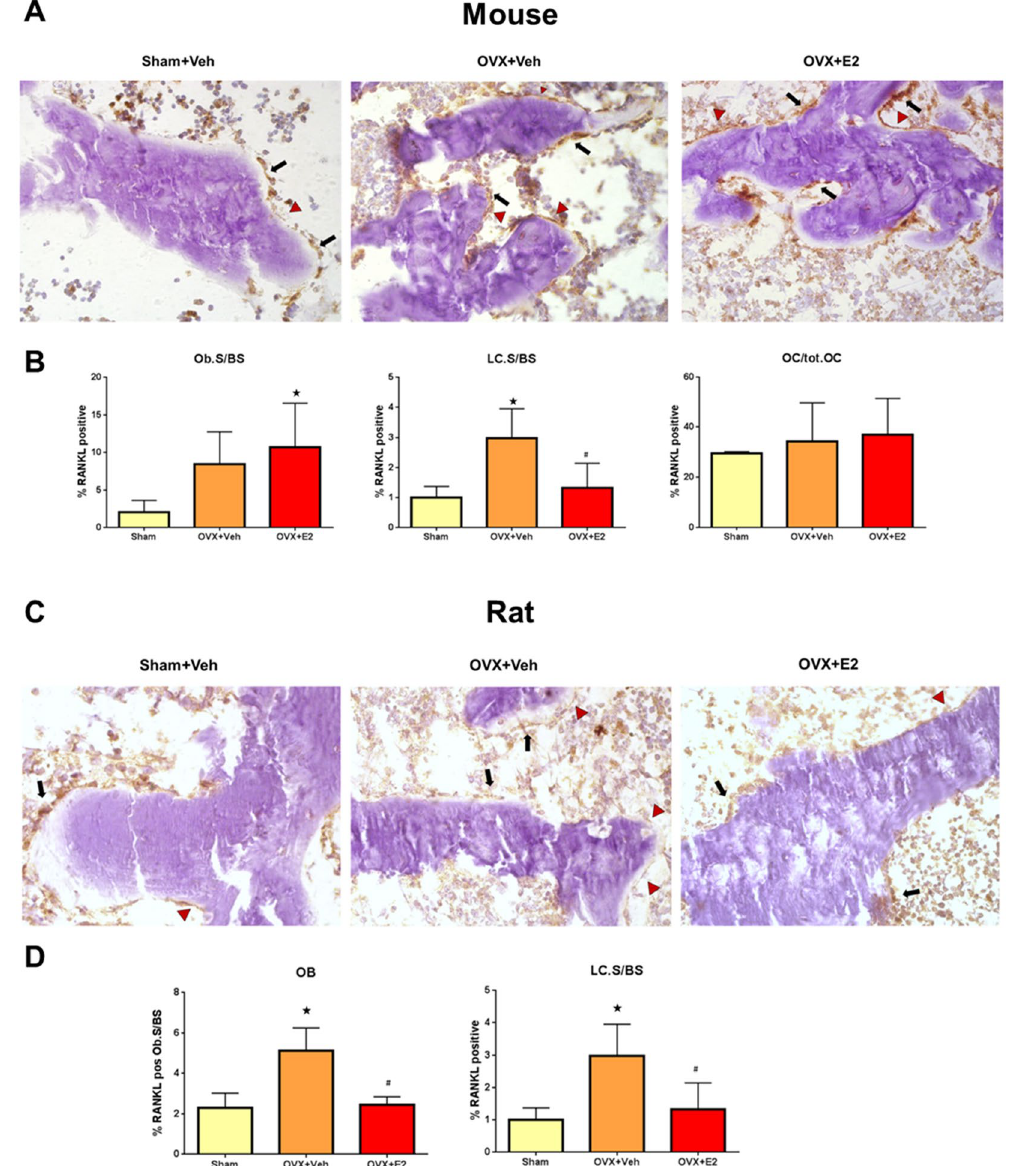
Figure 3. Estradiol targets RANKL expression in bone lining cells. ( A ) Anti-RANKL immunohistochemistry on cryosections of undecalcified distal femurs in vehicle-treated SHAM, and vehicle- or 17ß-estradiol (10 µ g/kg in B/R 5 times per week)-treated OVX WT mice, 2 weeks post-OVX. ( B ) Percent RANKL-positive osteoblasts per bone surface (BS), percent RANKL-positive bone lining cells (LC) per bone surface, and percent RANKL- positive osteocytes in vehicle-treated SHAM and vehicle- or E2-treated OVX WT mice, 2 weeks post-OVX. ( C ) Anti-RANKL immunohistochemistry on cryosections of undecalcified proximal tibias in vehicle-treated SHAM and vehicle- or E2 (2.5 µ g/kg in B/R 5 times per week)–treated OVX Fischer 344 rats, 2 weeks post-OVX. ( D ) Percent RANKL-positive osteoblasts per bone surface (BS) and percent RANKL-positive bone lining cells per bone surface in vehicle-treated SHAM and vehicle- or E2-treated OVX rats, 2 weeks post-OVX. Arrows in A and C mark RANKL-positive osteoblasts, arrowheads mark RANKL-positive lining cells. * In B and D denotes P < 0.05 vs. Sham, # denotes P < 0.05 vs. OVX + vehicle. Data in B and D are mean ± SD of 4–5 animals